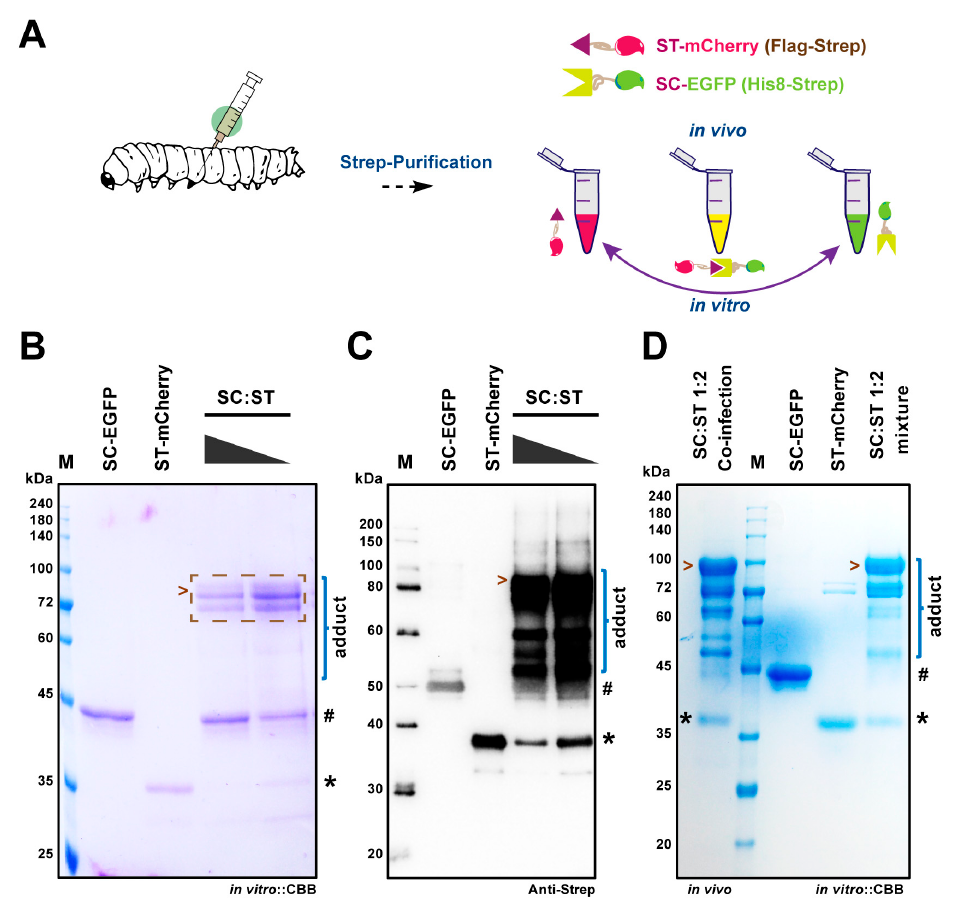
Figure 3. In vitro and in vivo protein ligation of ST/SC partners in silkworm-Spy-BEVS. ( A ) Diagram of expression and ligation of ST-mCherry and SC-EGFP proteins in silkworm-BEVS. Each protein was purified from the fat body of infected fat body and mixed in a decreased ratio of SC-EGFP/ST-mCherry (SC/ST) to investigate the in vitro ligation activity as demonstrated in ( B ) (CBB staining) and ( C ) (Western blot analysis by anti-Strep tag). The in vivo ligation was tested by co-infecting silkworm larvae with two recombinant baculoviruses of SC-EGFP and ST-mCherry (SC/ST = 1:2) together. The resulting products were purified by Strep-column and assessed by SDS-PAGE ( D ). # and * indicate SC-EGFP and ST-mCherry, respectively. Ligated products were marker by the brace and the completed adduct was marked by arrows.